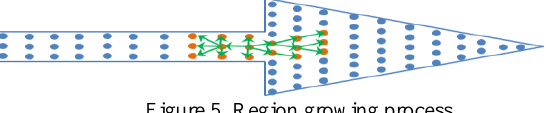
Figure 5. Region growing process